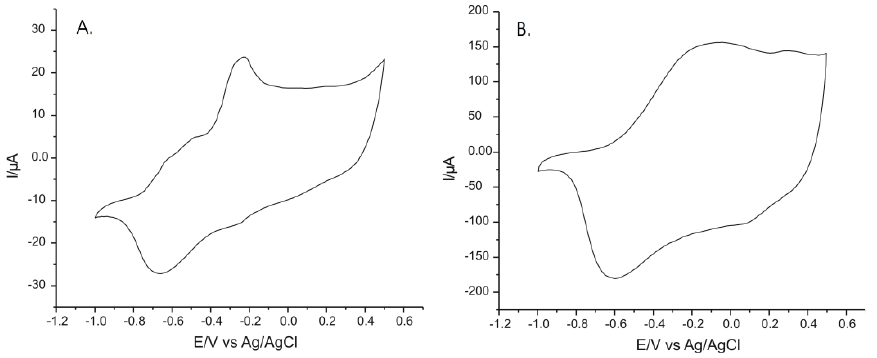
Figure 9. Voltammetric responses of the PPy/FeCN sensor in solutions of ( A ) Cebrium (EVER NEURO PHARMA) and ( B ) Sleep Optimizer (SOLARAY).